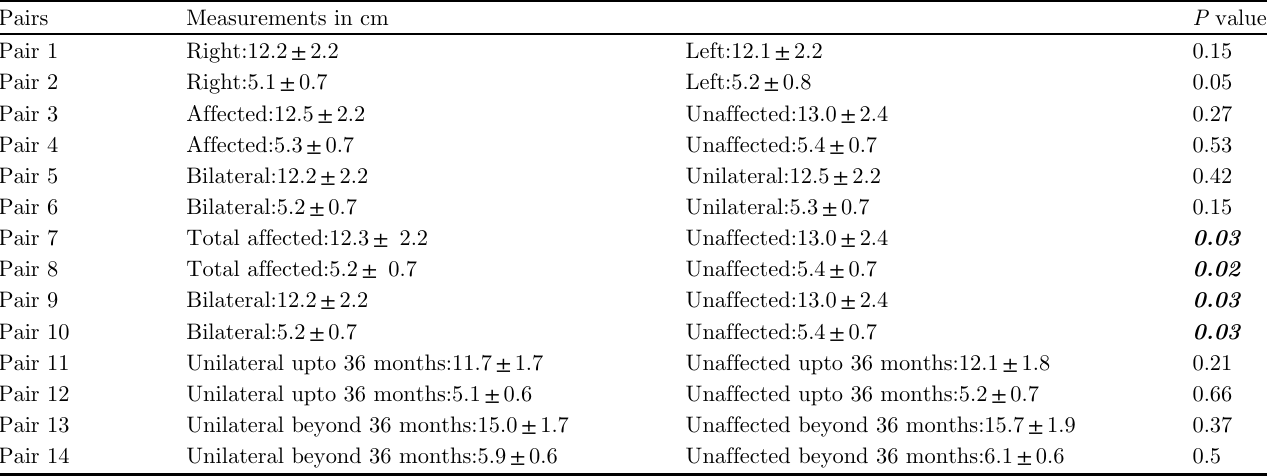
Table 1. Comparison of various pairs and their statistical signi fi cance *